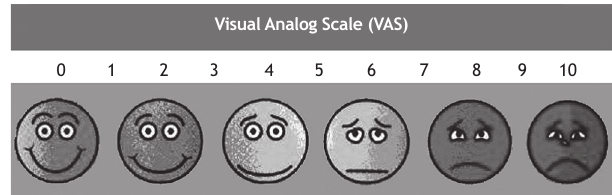
Figure 2 Visual analog scale model used. The higher the numeri - cal scale, the worse the level of discomfort.